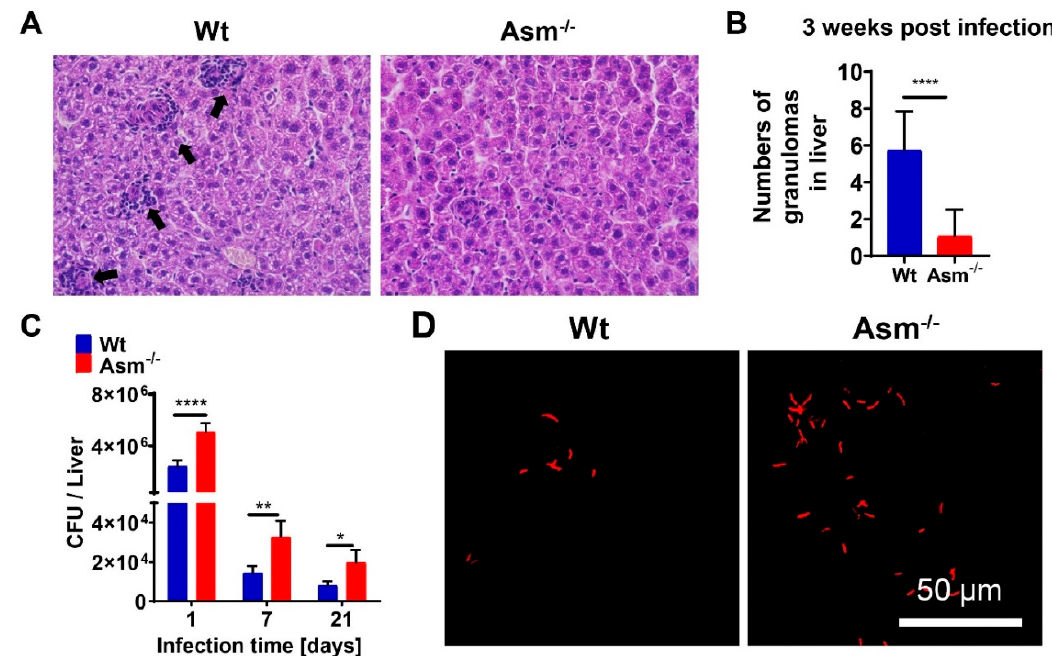
Figure 1. Acid-sphingomyelinase-deficient mice are more susceptible to BCG infection. Wild-type (wt) mice and acid-sphingomyelinase-deficient (Asm − / − ) mice were intravenously infected with 10 7 colony-forming units (CFU) of Mycobacterium bovis Bacillus Calmette-Gu é rin (BCG) for 1, 7, or 21 days. ( A , B ) Cryosections from liver tissues after 3 weeks of infection were stained with hematoxylin and eosin (H&E) and analyzed by light microscopy with a 20 × lens. Arrows indicate granulomas. Pictures are representative of at least 3 independent experiments. The number of granulomas was determined by counting them in 10 serial sections. Shown is the mean ± SD of granuloma per section, n = 4, t -test. ( C ) The total number of BCG in liver tissue homogenates after 1, 7, or 21 days of infection was determined by CFU assays. ( D ) BCG inside liver tissues after 3 weeks of infection were visualized by Truant staining with a 100 × lens. Scale bar = 50 µ m. Shown are means ± SD of numbers of bacteria ( C ), n = 4, ANOVA, statistical significance was set as **** p < 0.0001, ** p < 0.01, * p < 0.05 or representative pictures of at least 3 independent experiments ( D